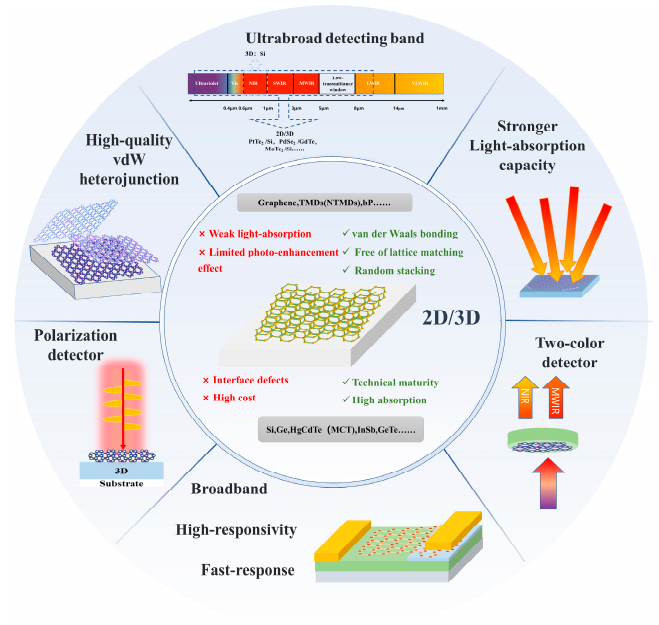
Figure 3. Advantages and disadvantages of 2D and 3D materials and the superiority of 2D/3D in- frared photodetection. infrared